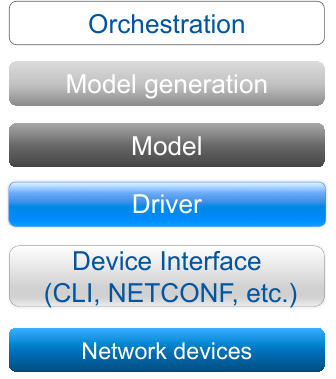
Figure 1: CERN networks complex.